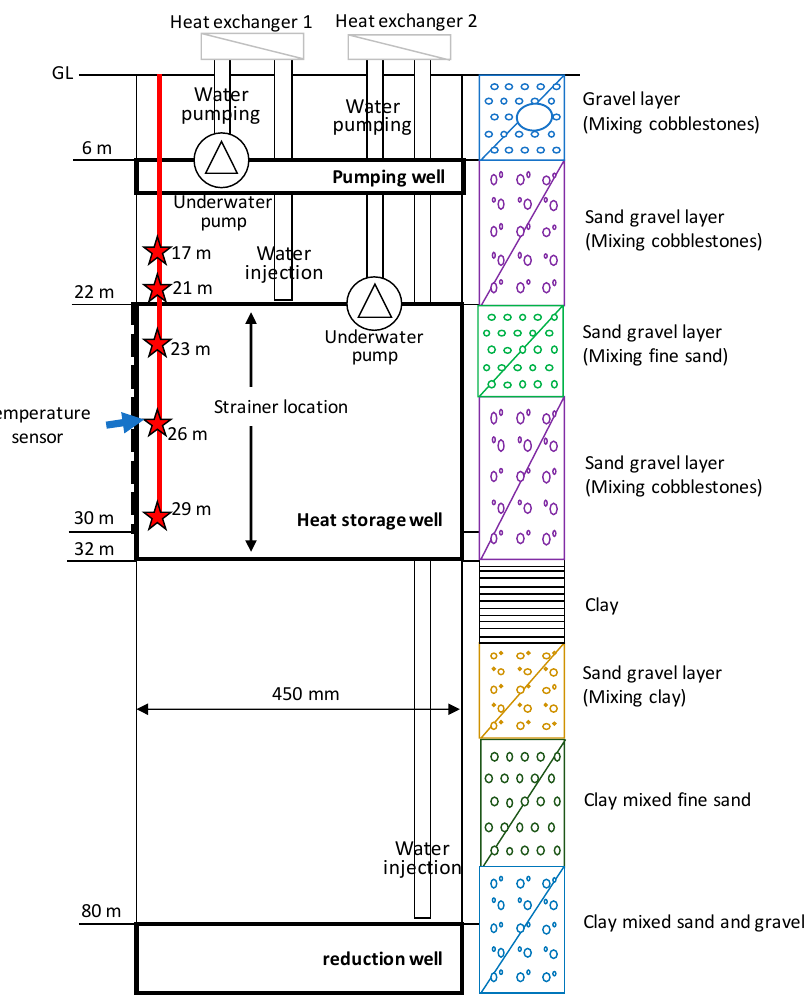
Figure 2. A conceptual diagram of the cylindrical model.